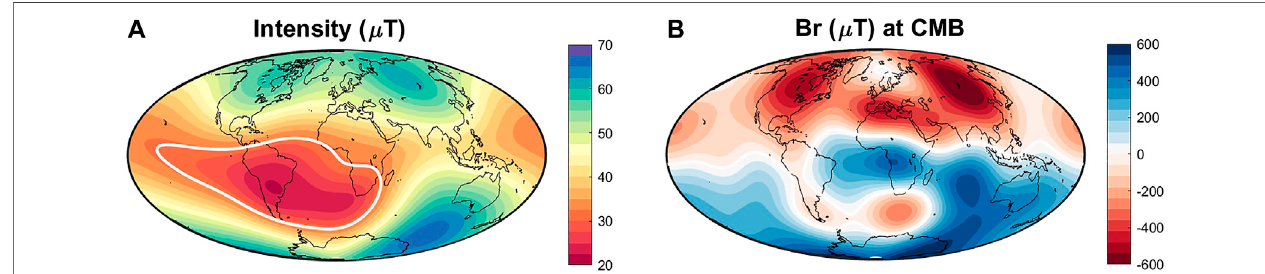
FIGURE 1 | Geomagnetic fi eld on January 1, 2020. (A) Intensity at the surface and (B) radial component (Br) of the geomagnetic fi eld at the CMB on January 1, 2020, from CHAOS-7.2 model (Finlay et al., 2020). The white line in (A) marks the contour line of 32,000 nT to highlight the area of the SAA de fi ned following De Santis etal.(2012).In (B) thetwoRFPsrelatedtothepresenceoftheSAAatthesurfaceareobservedinredcolorsintheSouthernHemisphere.WeuseCHAOS-7.2modeluntil degree 13 to calculate the intensity at the surface and until degree six for Br at the CMB.